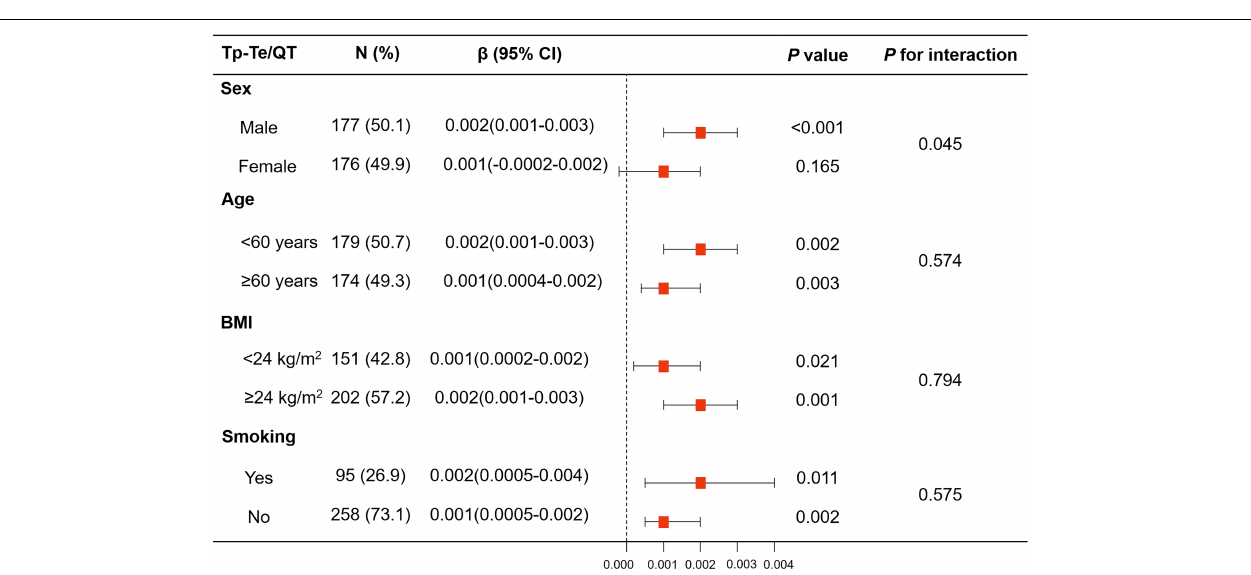
FIGURE 4 | Linear regression model of HAM-A score for Tp–Te/QT ratio in subgroup analyses stratified by sex, age, BMI, and smoking. The associations of HAM-A score with Tp–Te/QT ratio showed significant interaction with sex, while there was no interaction with age ( < 60 years vs. ≥ 60 years), BMI ( < 24 kg/m 2 vs. ≥ 24 kg/m 2 ), and smoking. BMI, body mass index; HAM-A, Hamilton anxiety scale; QT interval, Q wave start to T wave end interval; Tp–Te interval, T-wave peak to T-wave end